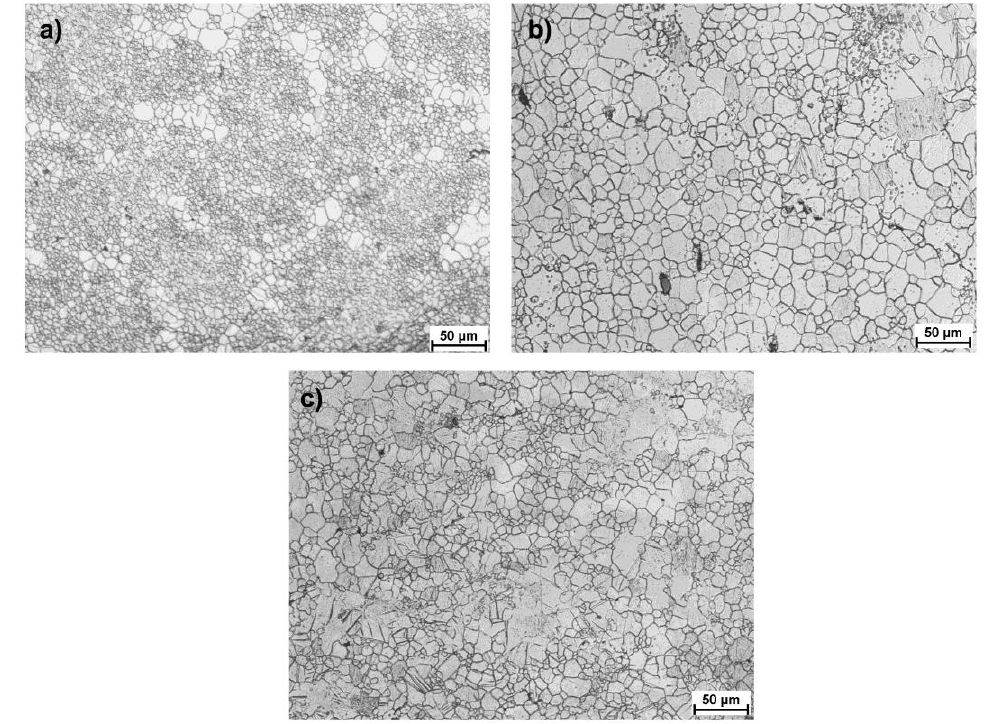
Figure 11. Microstructure obtained for finished bars with the diameter of 15 mm rolled according to Variant II, defined for ( a ) surface zone, ( b ) middle zone, ( c ) central zone.